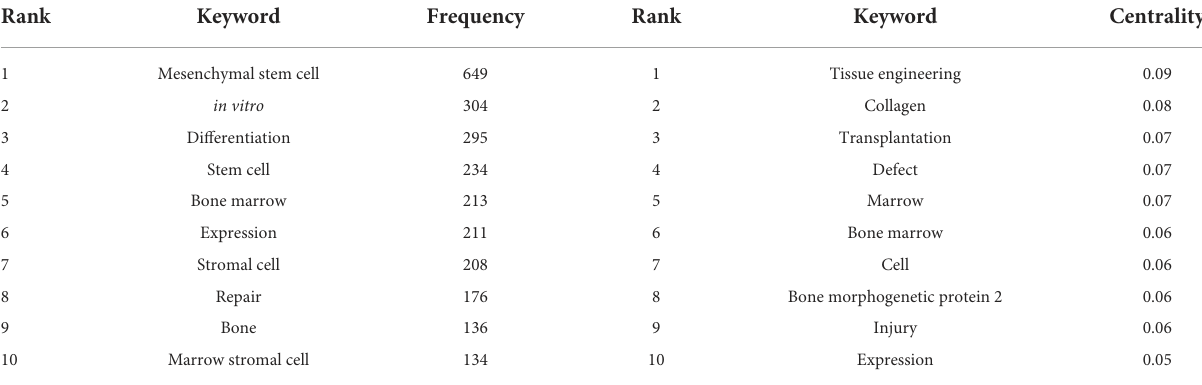
TABLE 5 The top 10 keywords co-occurrence frequency and centrality